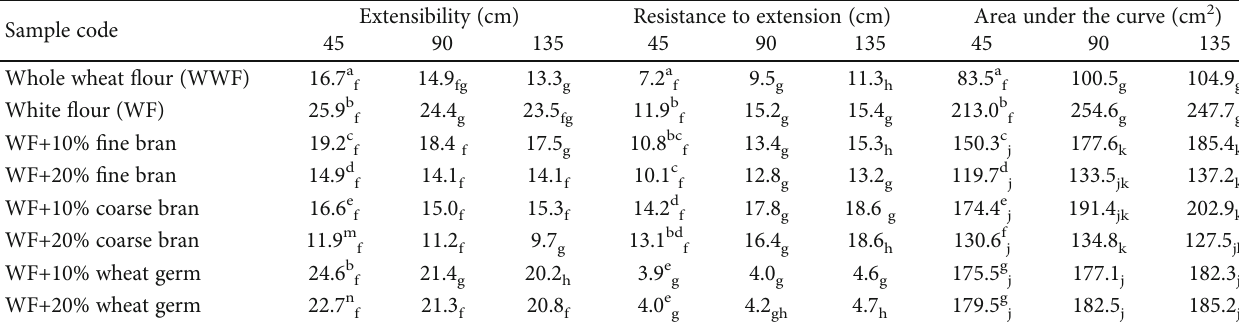
Table 7: Extensograph characteristics of dough made from fl our, germ, bran fractions, and psyllium blends. Sample code